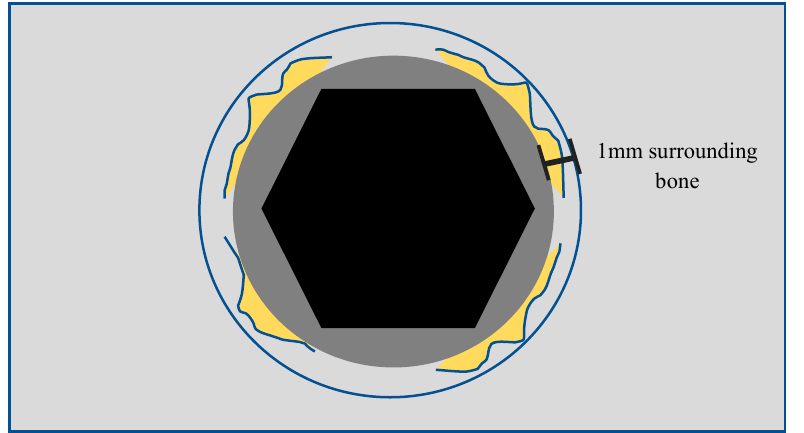
Figure 5. Diagram of the area of bone analyzed: 1 mm around the implant surface.